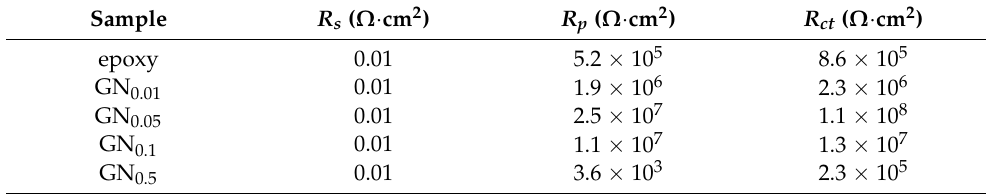
Table 2. Fitted equivalent circuit parameters of EIS for samples immersed in 3.5 wt.% NaCl